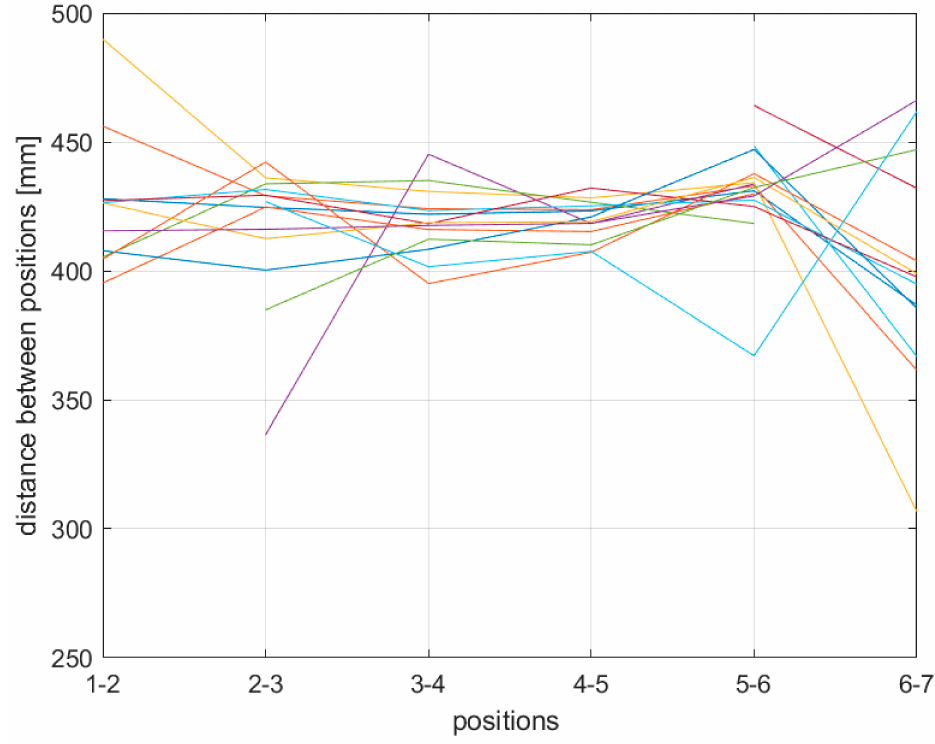
Figure 13. Body joint relative accuracy measurements of Kinect v1.